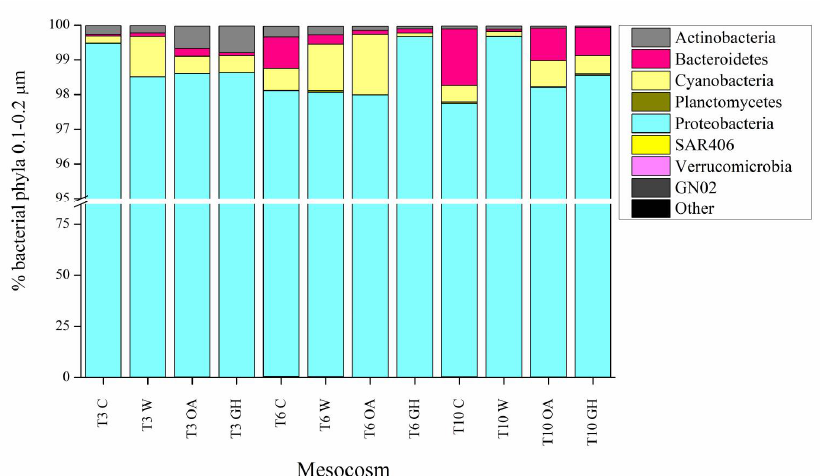
Figure 4. Percentage contribution of bacterial phyla (0.1–0.2 µ m fraction) in the mesocosms at T3, T6 and T10. “Other” phyla include Acidobacteria, Chlamydiae, Chloroflexi, Firmicutes, TM6, TM7 and ZB3. For the treatment abbreviations, please refer to Figure